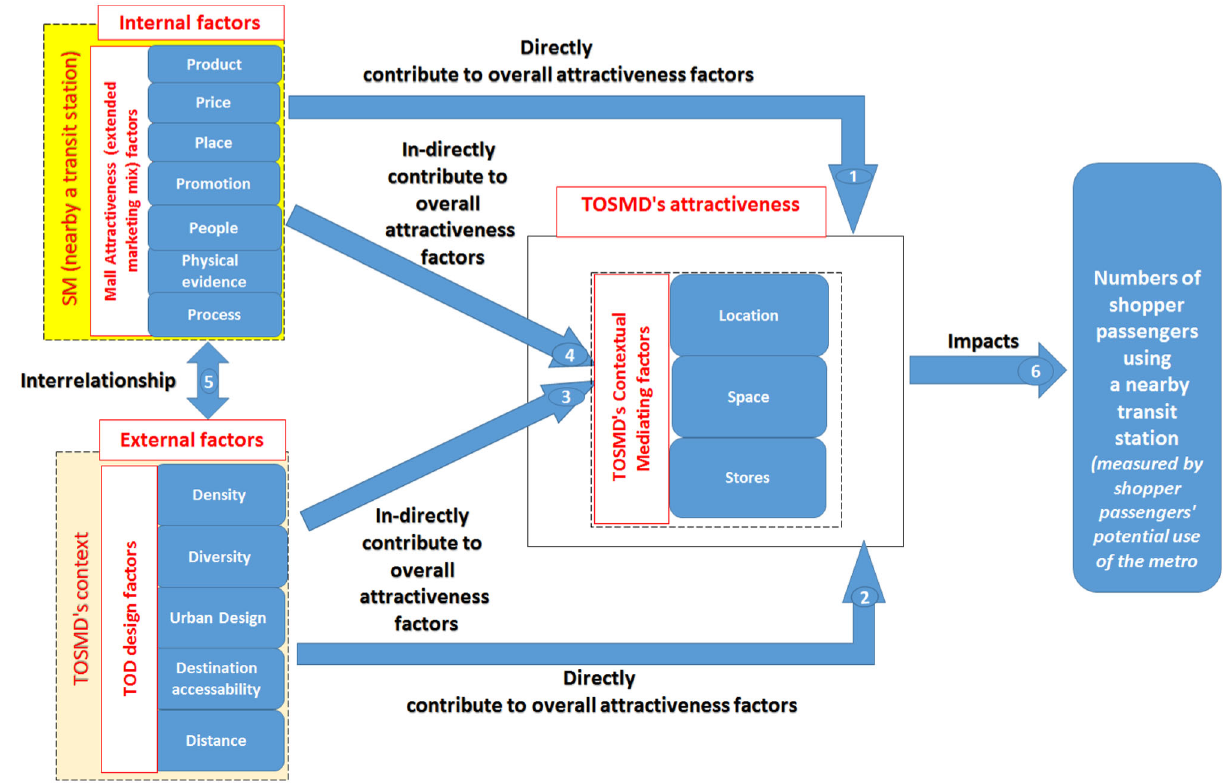
Fig. 8 The proposed conceptual framework for TOSMD